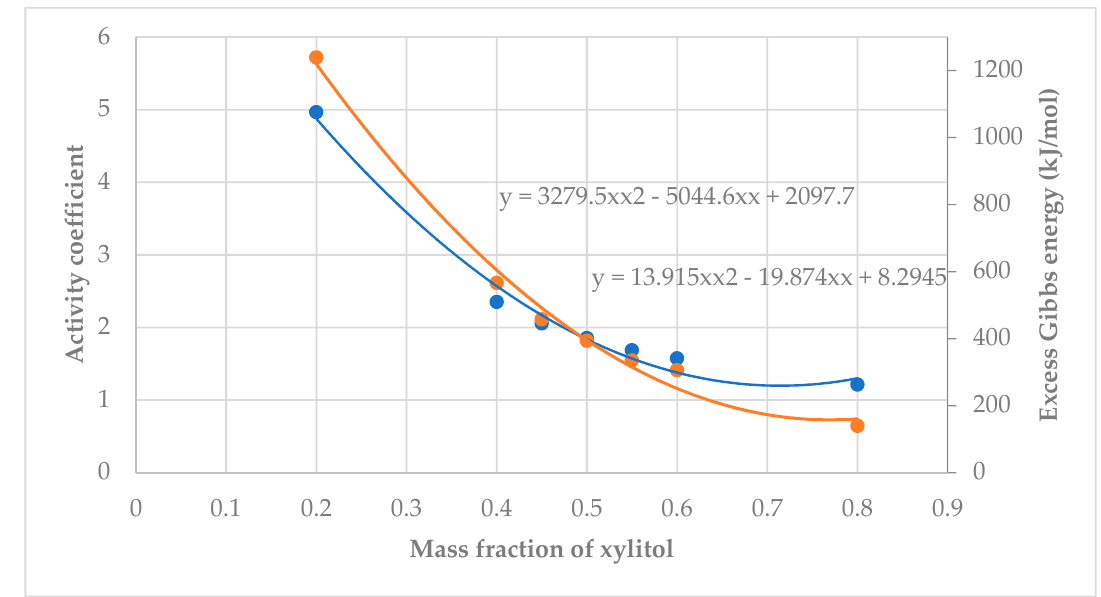
Figure 10. Relationship between mass fraction of xylitol, activity coefficient (blue), vs. Excess Gibbs Energy (orange).